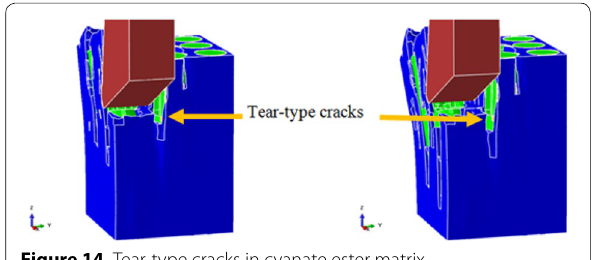
Figure 14 Tear-type cracks in cyanate ester matrix